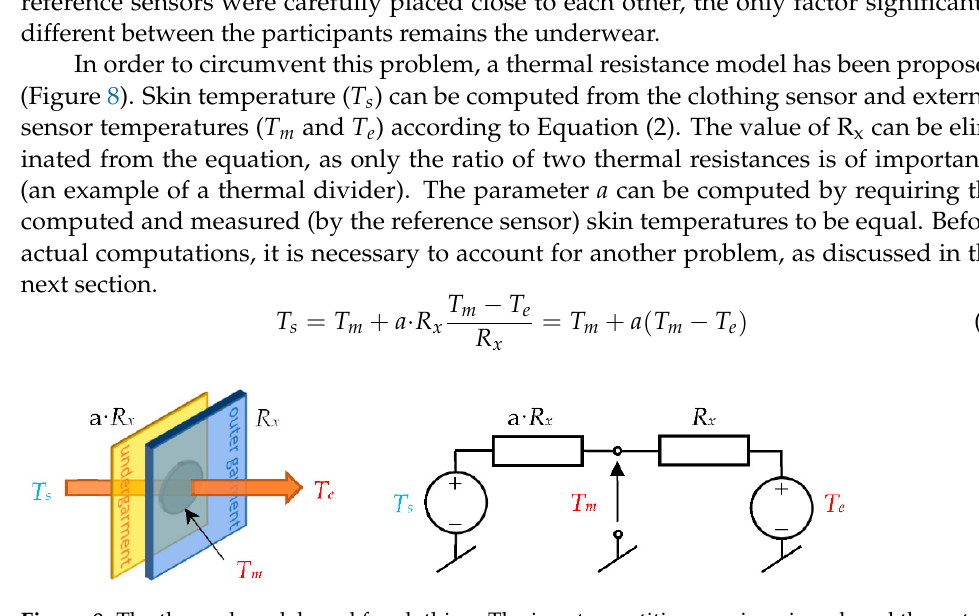
Figure 8. The thermal model used for clothing. The input quantities are given in red, and the output in blue.